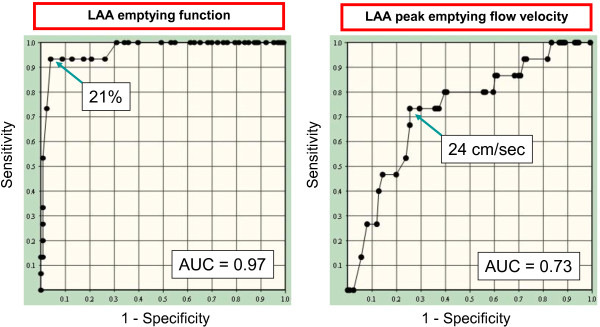
Receiver operating characteristic curves for the prediction of left atrial appendage thrombus in 140 persistent atrial fibrillation patients with low CHADS2 score (≤1). LAA: left atrial appendage, AUC: Area under the curve.